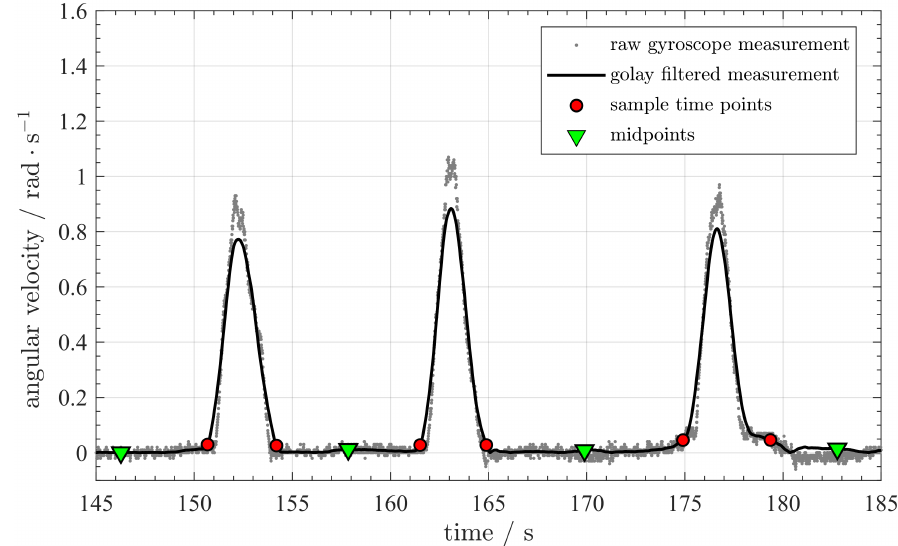
Figure 7. Extracting the time interval when a beacon moves in straight lines. The magenta points denote the sample points where the straight moving interval starts and ends. The green points are the midpoints of time in the straight moving